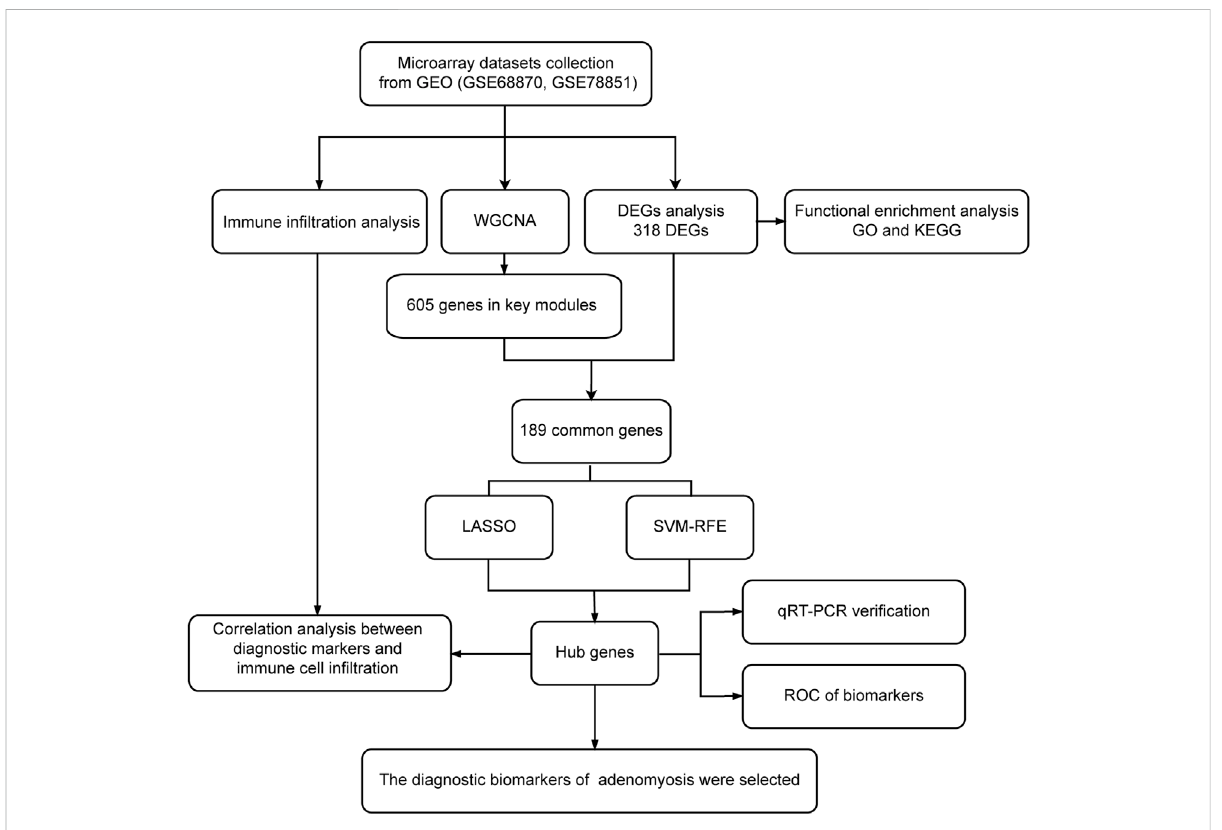
FIGURE 1 Flowchart of this study. Microarray datasets analysis was conducted for endometrium samples from nine women with adenomyosis and seven healthy controls. DEGs: differentially expressed genes; GEO: Gene Expression Omnibus; GO: Gene Ontology; KEGG: Kyoto Encyclopedia of Genes and Genomes; LASSO: the least absolute shrinkage and selection operator; qRT-PCR: quantitative reverse transcriptase PCR; ROC: receiver operatingcharacteristic;SVM-RFE:thesupportvectormachine-recursivefeatureelimination;WGCNA:weightedgeneco-expression network